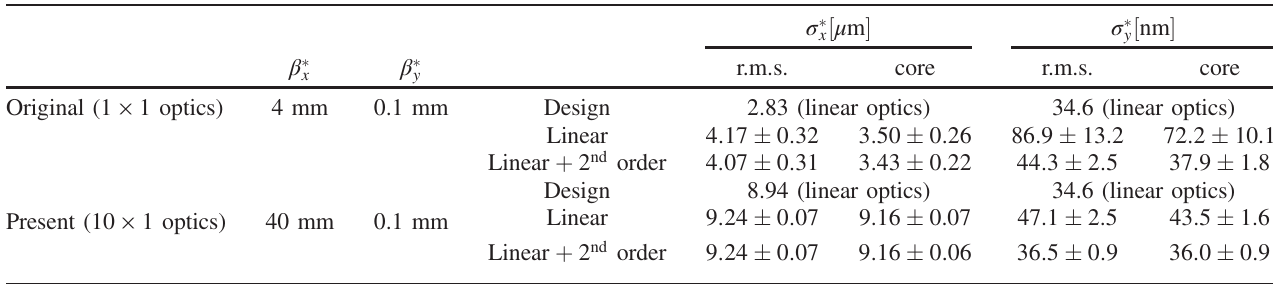
TABLE IV. Simulated beam sizes with and without second order optics knobs for the original and present ATF2 optics. “ rms beam size ” is the standard deviation of the y distribution of the tracked particles at the IP. “ Core beam size ” is the width of a Gaussian function fitted to the core of this distribution. The (cid:3) shows the standard deviation of the simulated beam size at the